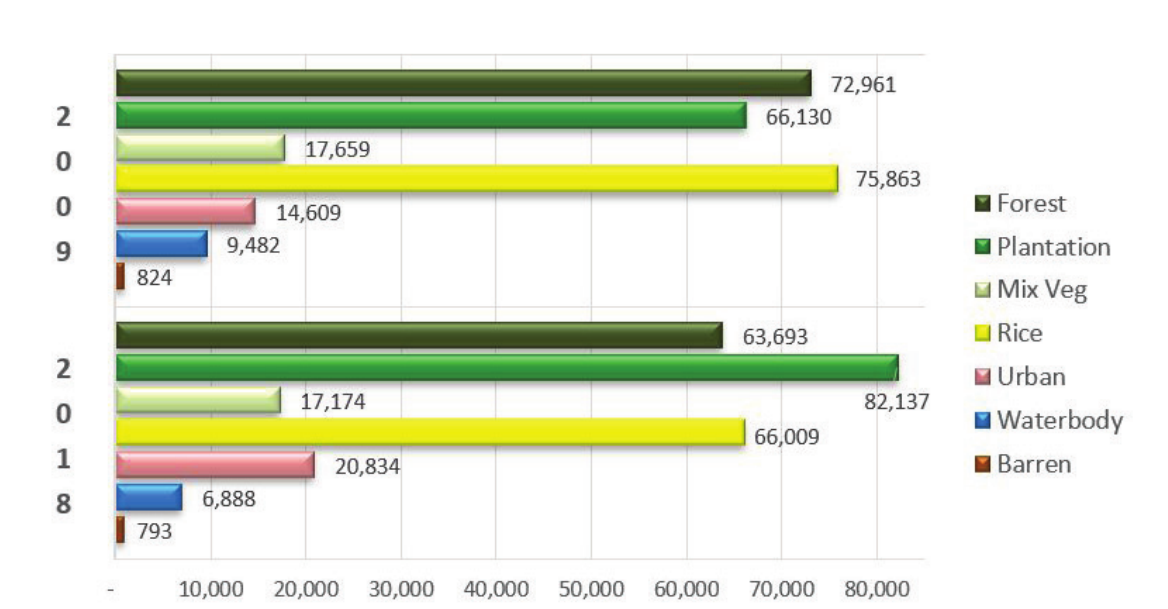
Figure 4. The coverage of classified landuse (ha) in 2009 and 2018.